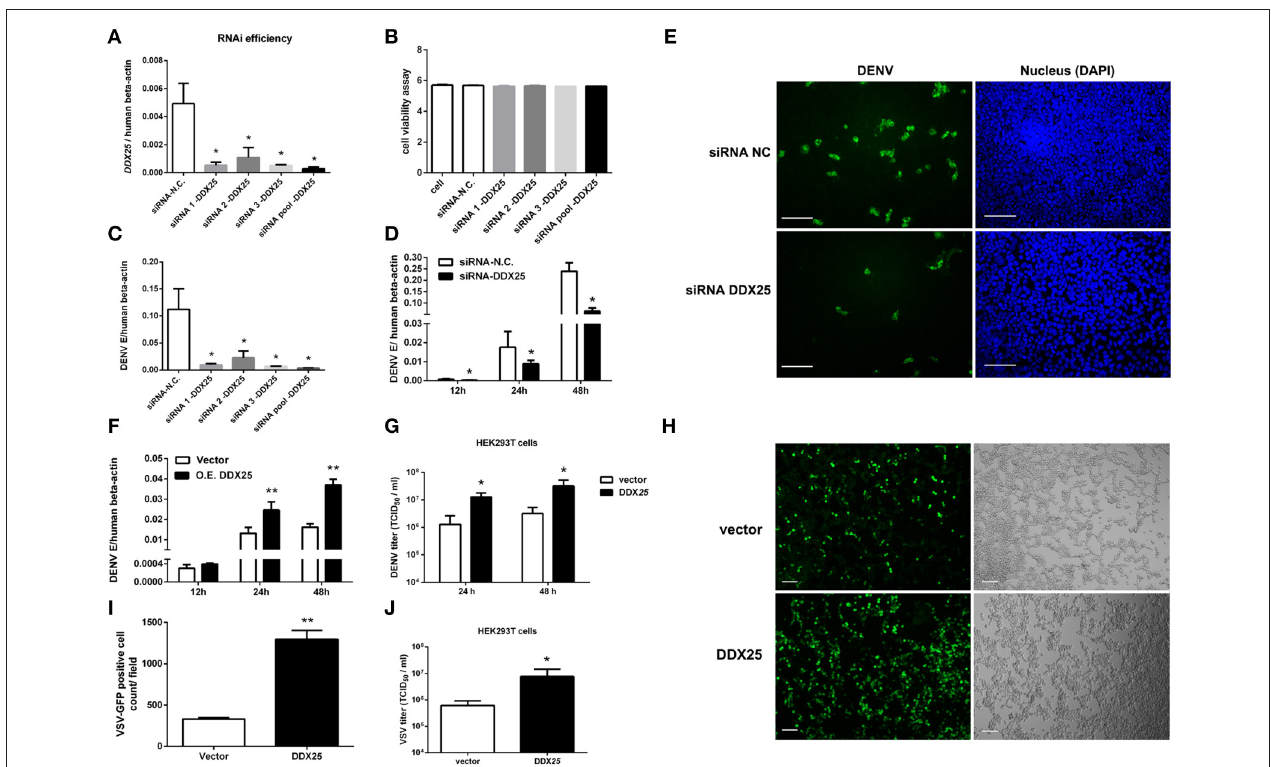
FIGURE 2 | DDX25 promotes virus replication. (A) The RNAi efficiency of three individual or pooled siRNAs that targeting DDX25 were tested in transfected HEK293T cells by qRT-PCR. (B) RNAi of DDX25 showed no cytotoxic effect to HEK 293T cells (Measured by Cell Viability assay, Promega). (C) DENV viral loads in DDX25 siRNAs (or NC siRNA) treated HEK293T cells at 24 h post DENV infection (MOI of 1). The viral burdens were analyzed by measuring the virus E gene copy using qRT-PCR, and normalized to human β -actin . (D) DENV viral loads in DDX25 siRNA (or NC siRNA) treated HEK293T cells at 12, 24, and 48 h post DENV infection (MOI of 1). (E) Microscopic images of immunofluorescence staining for DENV E antigen in DDX25 siRNA (or NC siRNA) treated HEK293T after DENV infection for 24 h (MOI of 1). Scale bars, 100 µ m. (F) qRT-PCR analysis of DENV viral loads in HEK293T cells with or without DDX25 overexpression at 12, 24, and 48 h post DENV infection. (G) Viral titers in supernatants of DENV infected HEK293T cells determined by TCID 50 assay on Vero cells. (H,I) Fluorescence microscopy analysis of VSV-GFP infection of HEK293T cells transfected with vector or DDX25 plasmid. Viral infection rates were indicated with GFP signal and quantified with ImageJ software. Scale bars, 100 µ m. (J) VSV titers in supernatants of HEK293T cells infected with VSV-GFP (MOI of 1) at 24 h. Results were expressed as the mean + the SEM. * p < 0.05 and ** p < 0.01 ( t -test). Representative results from at least three independent experiments.